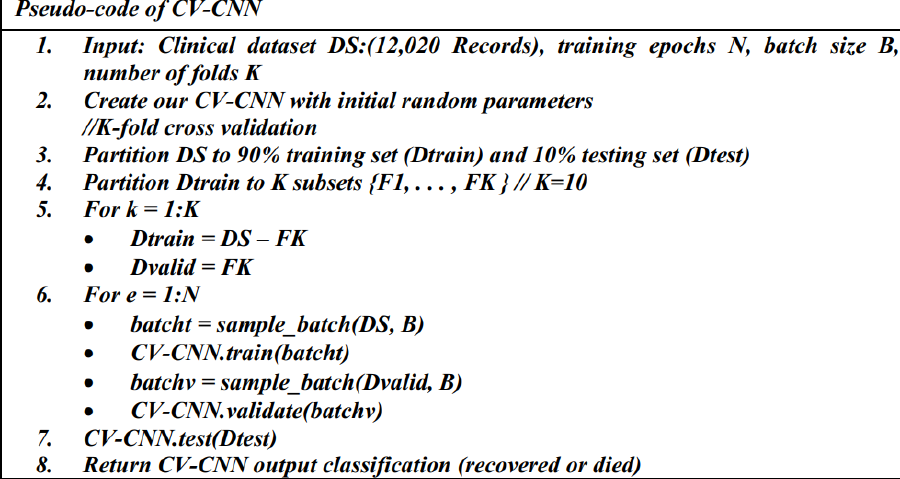
Figure 6. The pseudo-code of the CV-CNN model.